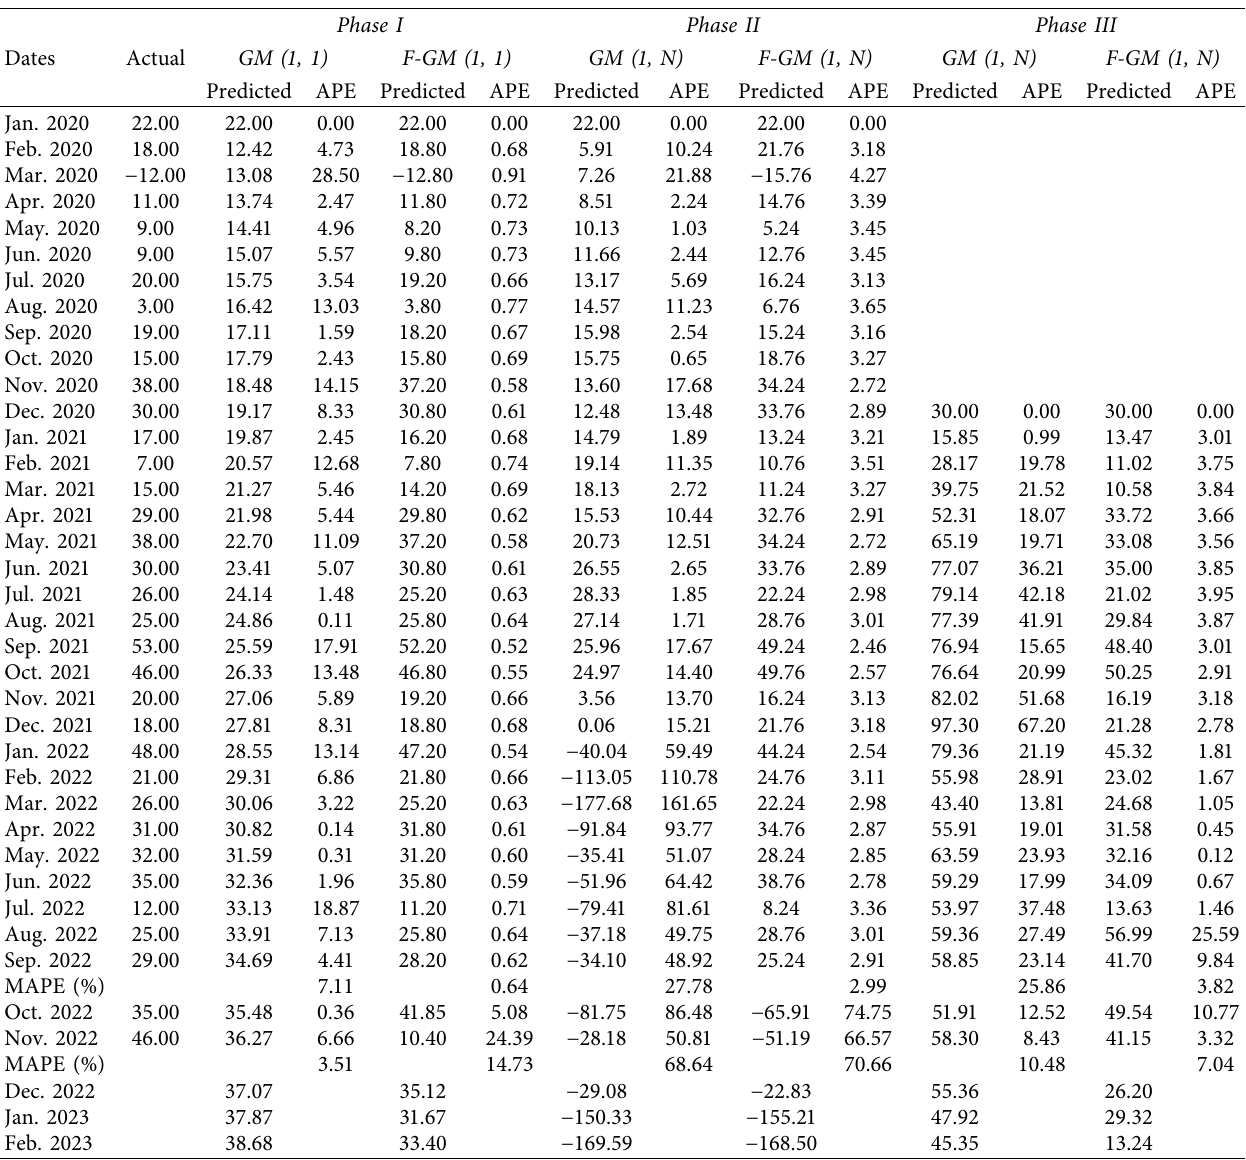
Table 7: Prediction results of travel sentiment in Germany.